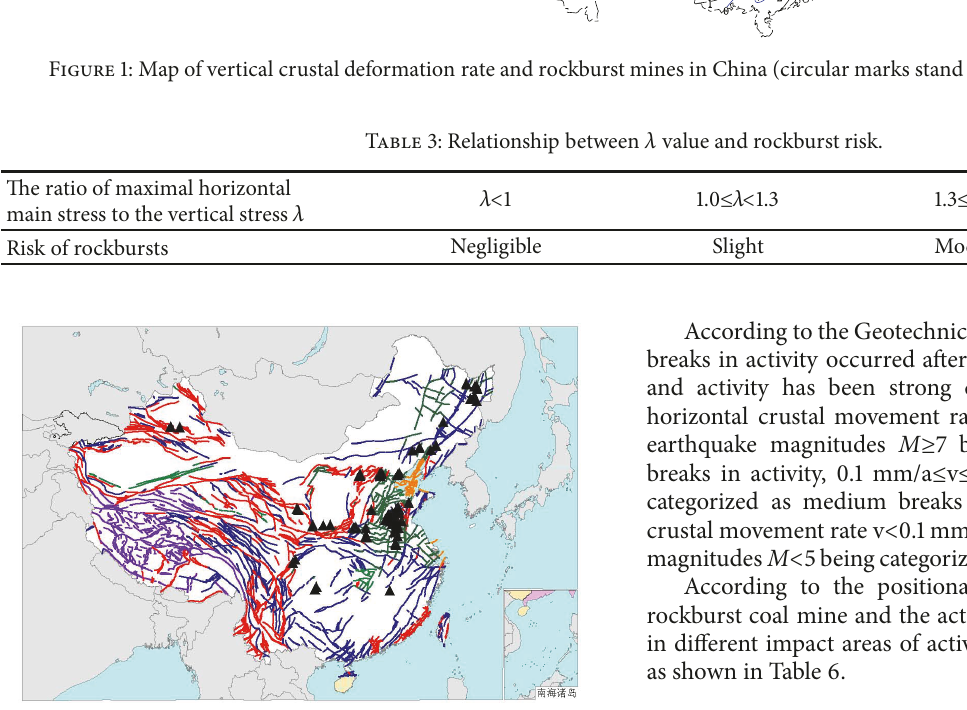
Figure 2: Active faults and rockburst coal mines distribution in China (triangle marks stand for rockburst coal